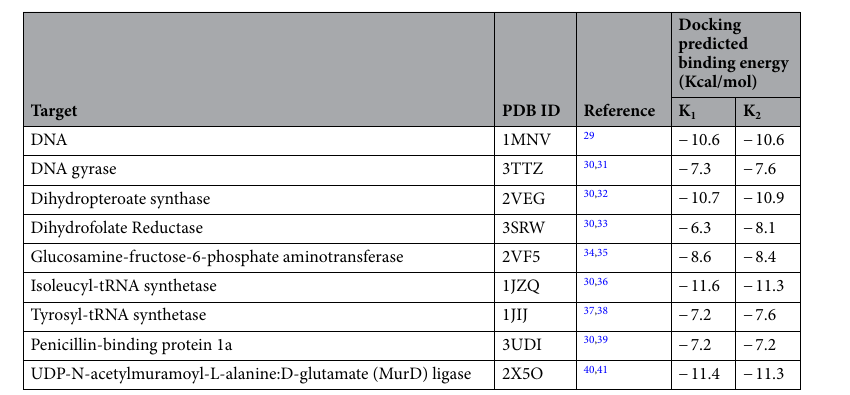
Table 4. One-way ANOVA for primary antimicrobial activity of isolated actinomycins X 2 , D, and X 2 + D. a Asymptotically F distributed.